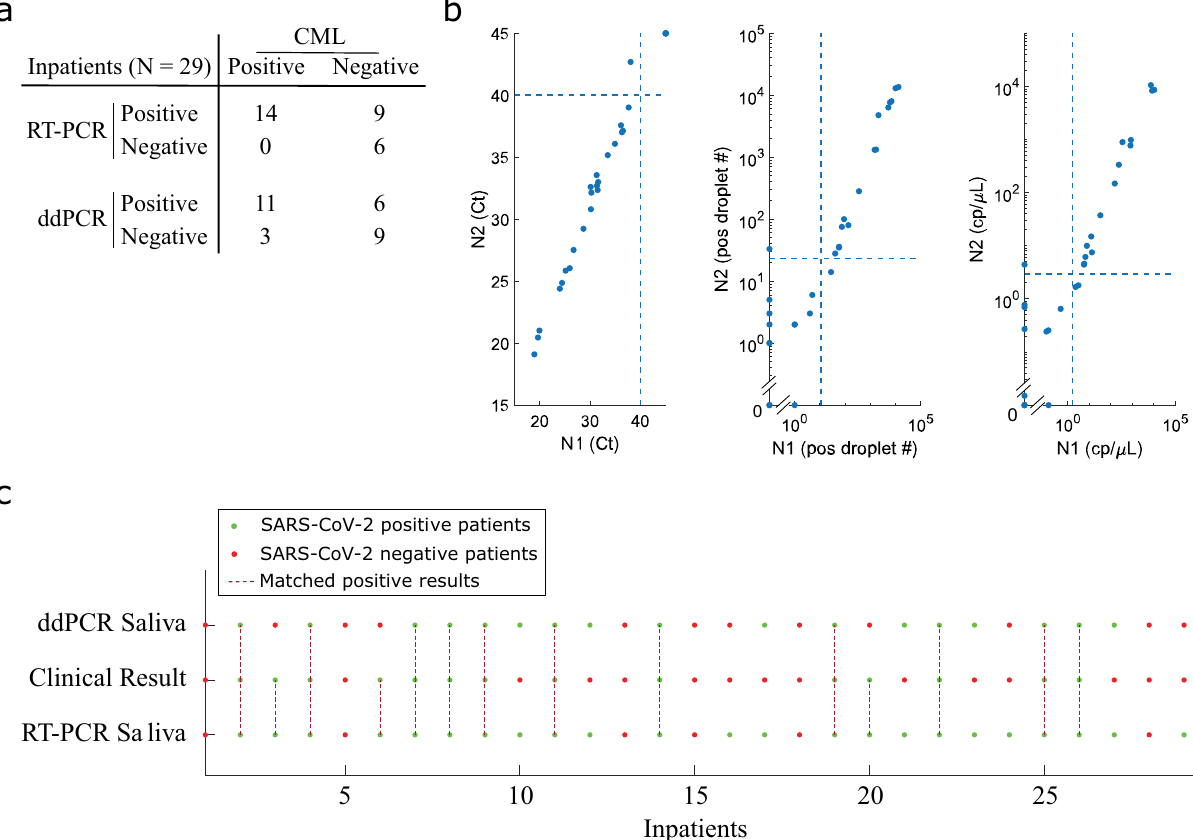
Figure 5. Analysis of nasal swab and saliva samples collected from 29 inpatients hospitalized for COVID-19. ( a ) Table summarizes results of our research-based RT-PCR and ddPCR assays compared to CML nasal swab testing. Each number in the table represents cases detected as positive or negative by our assays and by the CML. For example, our saliva RT-PCR assay detected all (14 out of 14) positive patients that are detected as positive by the CML. On the other hand, our RT-PCR saliva assay detected an additional 9 positive patients that are deemed as negative by the CML. ( b ) The figure demonstrates N1 vs N2 target gene concordance assessed by RT-PCR Ct values (left), ddPCR positive droplet number (middle), and ddPCR copy number per µL (right). The dashed lines in each subplot indicate empirical thresholds for positive readout calling. ( c ) The comparison of matched saliva-based RT-PCR and ddPCR results with NS-based results generated by the diagnostic facility. For saliva ddPCR assay, a sample is called positive if either N1 or N2 are above the empirical thresholds. For saliva-based RT-PCR assay, a sample is called positive if either N1 or N2 show Ct values < 40. The green dots indicate positive sample status, while red dots indicate samples tested negative in respective settings. The maroon dashed lines indicate samples tested positive by the respective